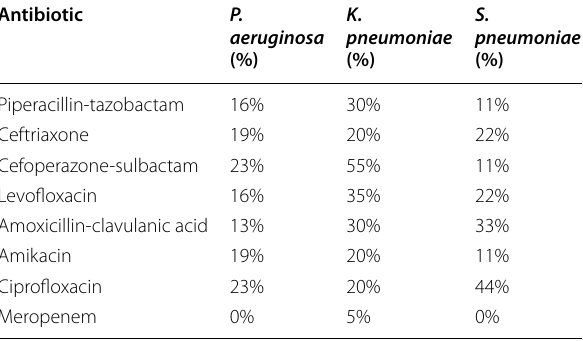
Table 5 Antibiotic resistance pattern of specific isolates